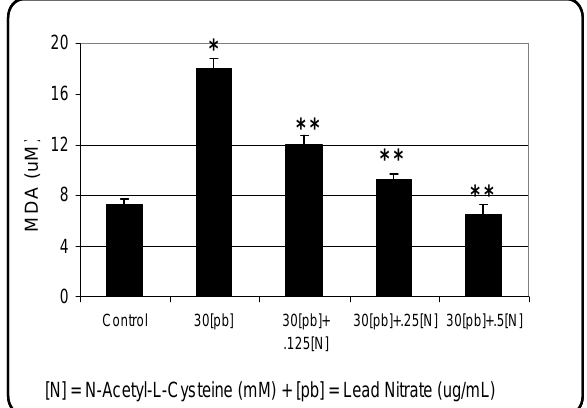
Figure 4 : Protective effect of NAC on lead nitrate- induced oxidative stress in HepG cells. Cells were 2 incubated for 48 hr with 30 µg/mL lead nitrate and various concentrations of NAC (0.125, 0.25, and 0.5 mM). Malondialdehyde formation was determined as described in Materials and Methods. *Significantly different from the control by ANOVA Dunnett’s test; p < 0.05. **Significantly different from ATO alone by ANOVA Dunnett’s test; p < 0.05. Data are representative of 3 independent